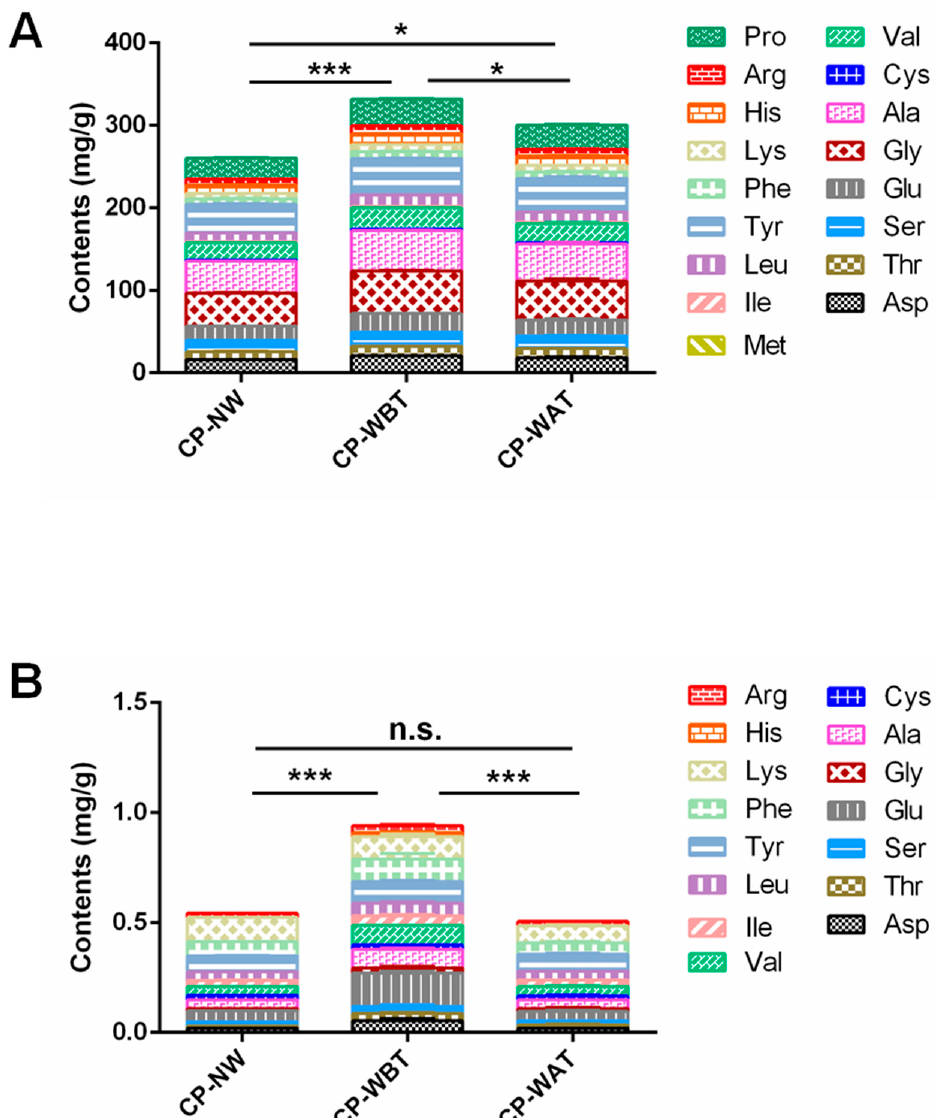
Figure 4. Total contents of amino acids in three kinds of CP samples. ( A ) hydrolyzed amino acids (HAA); ( B ) free amino acids (FAA). Data represent means ± SD, n = 3. *** p < 0.001, * p < 0.05. 2.5. Comparison of DPPH and ABTS Radical Scavenging Rates of Three Kinds of CP